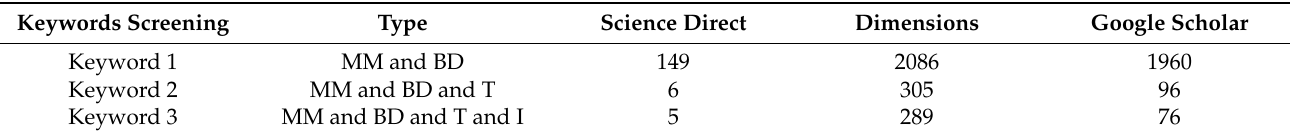
Table 1. Number of publications from three databases with three types of